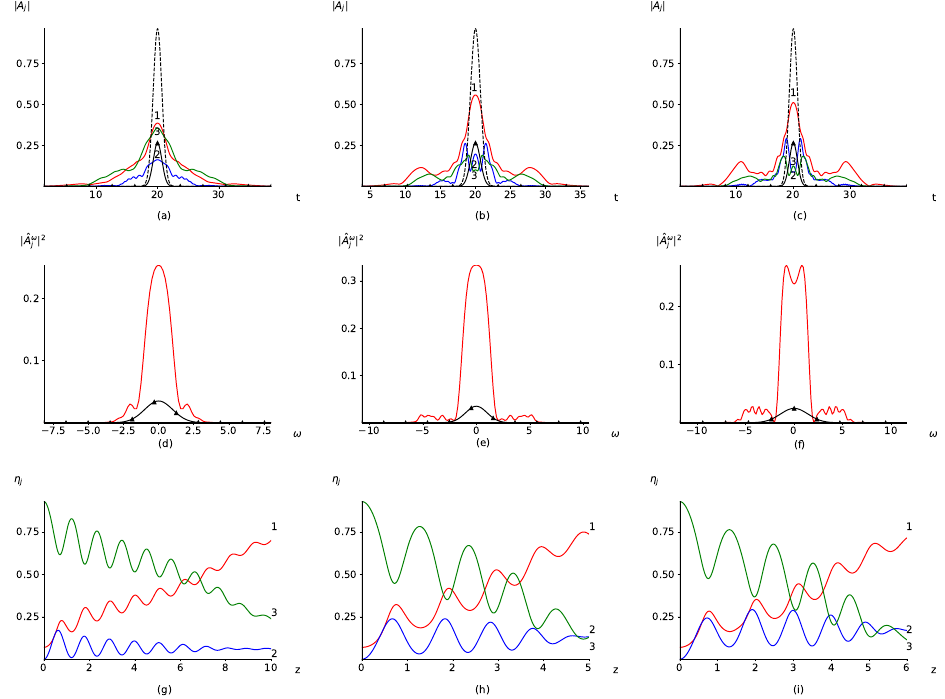
Figure 6. Pulse shapes in the section z = 10 ( a ), 5 ( b ), 6 ( c ), corresponding to the LFW Fourier spectrum ( d – f ) and the frequency conversion efficiency evolution ( g – i ) along the z -coordinate computed for ( c ) = ( 0, 0, 1 ) ( a , d , g ), ( 0, 0, − 1 ) ( b , e , h ), ( − 1, 0, 1 ) ( c , f , i 1 , c 2 , c 3